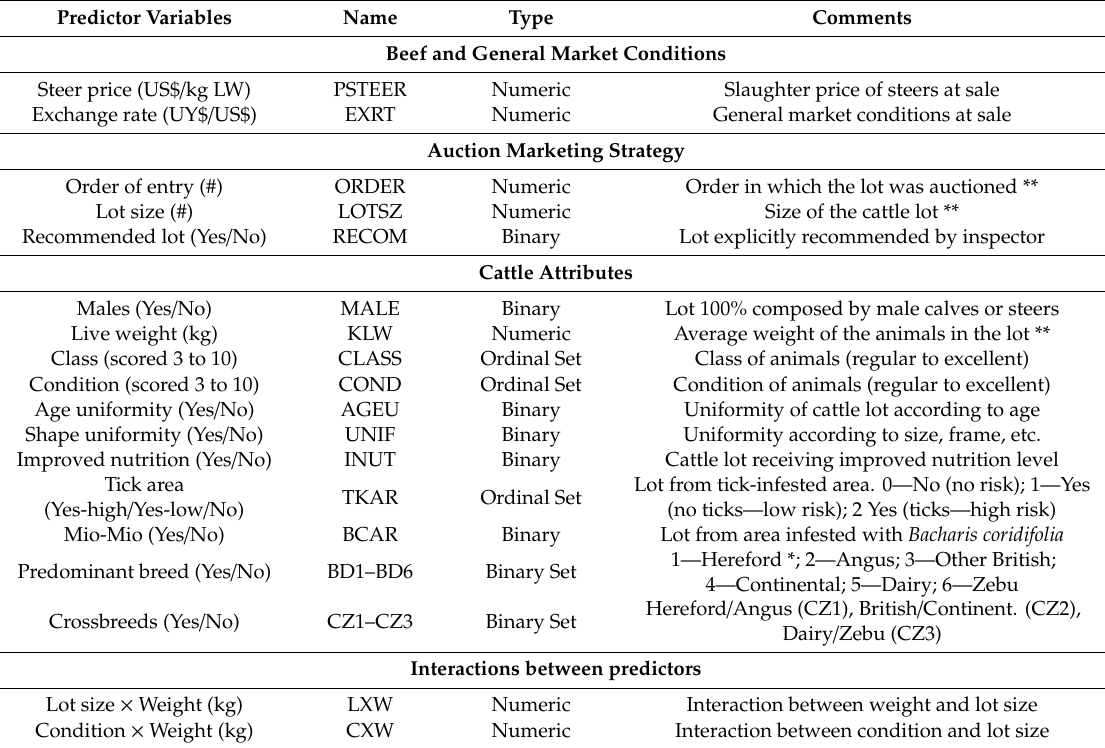
Table 1. Market and cattle characteristics used as predictor variables.